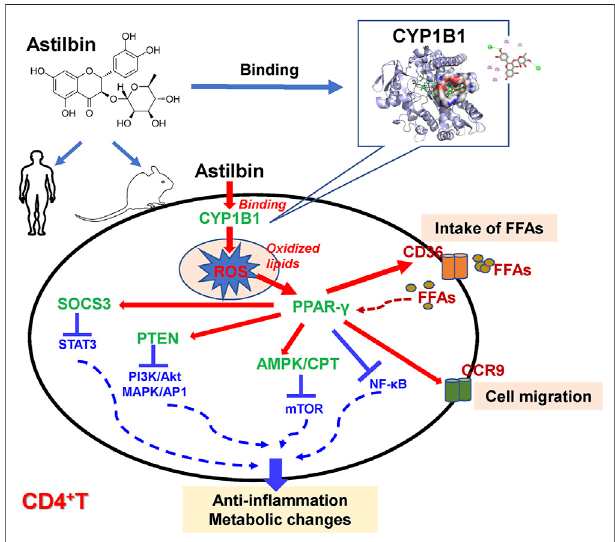
FIGURE 8 | Diagram of astilbin-modulated functions of CD4 + T